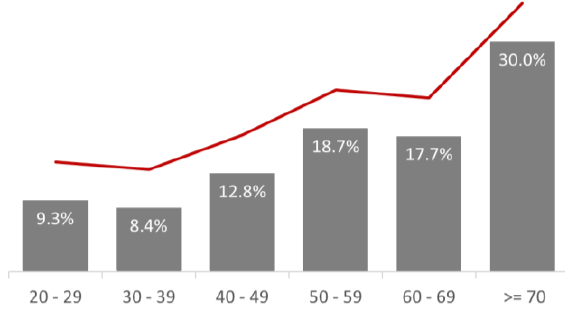
Figure 8. ‘ Women and Kids ’ spending by age band.